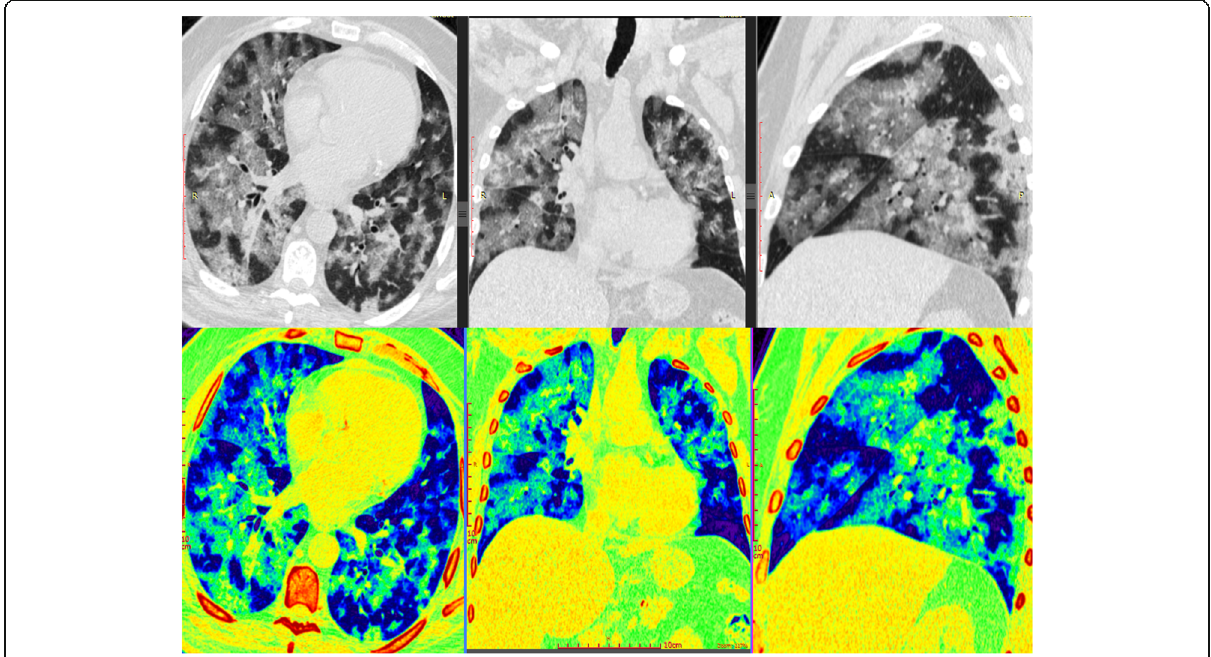
Fig. 3 A 55-year-old female patient presented with fever, dyspnea, and cough. MSCT scan with multi-planar and color-coded images showed widespread confluent bilateral peripheral and central predominant ground glass opacities with septal and vascular thickening. CT-SSS was 19 and